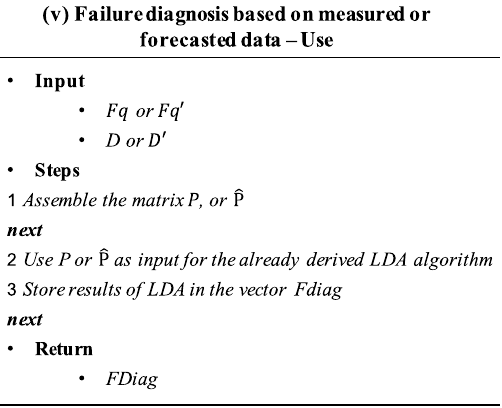
Figure 8. Pseudo-algorithm for the diagnosis process in step v.